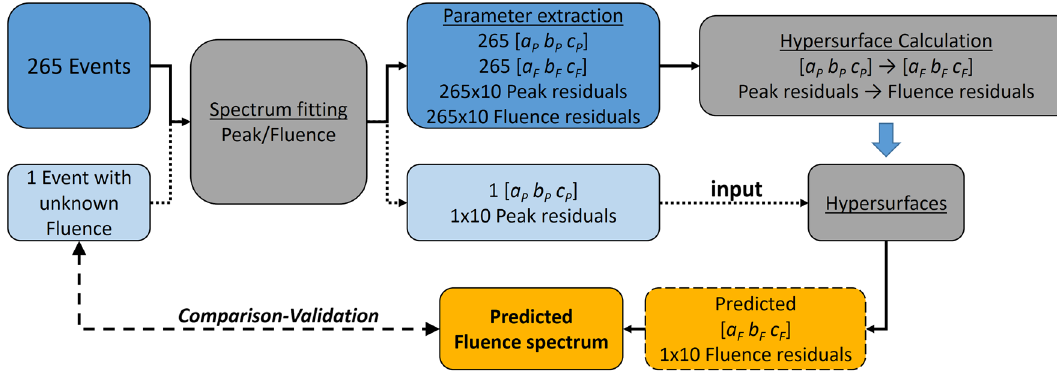
Fig. 10. The process used for the “ leave-one-out ” validation of the Fluence predictions.